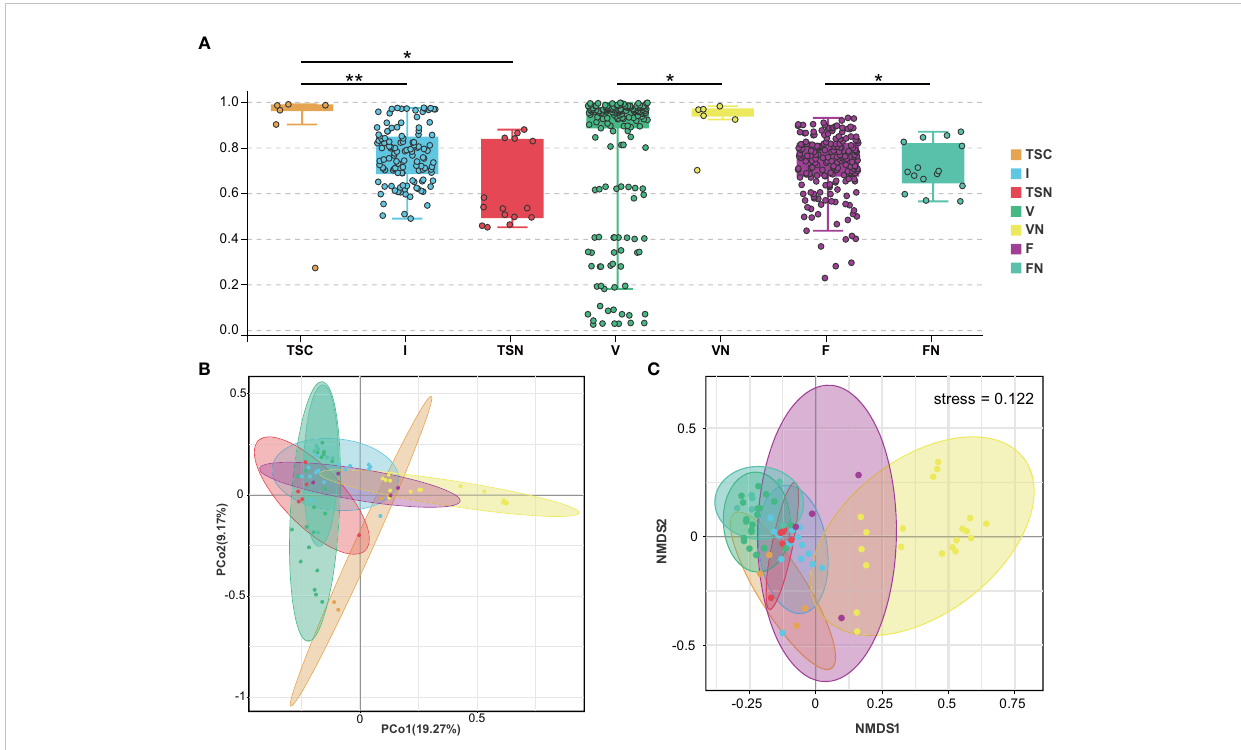
FIGURE 2 Visualization of beta-diversity index (A) , PcoA (B) , and NMDS (C) . These plots were conducted basing on Bray-Curtis Distance. Each dot represents one sample. In (A) , mean beta-diversity (distance from centroid) ± standard error.Statistical signi fi cance is displayed as *P < 0.05 and **P < 0.01. TSC,